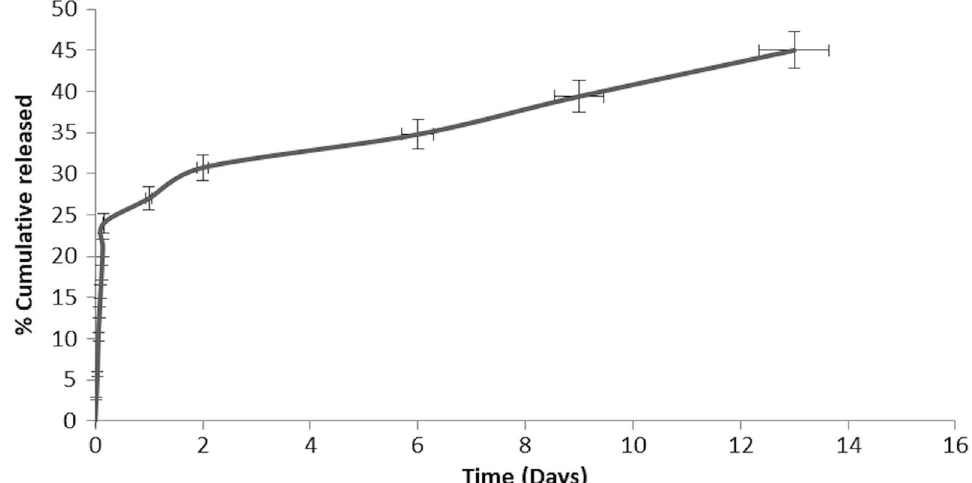
Fig. 9 In vitro release profile of SM from the prepared SM-NP-Tw